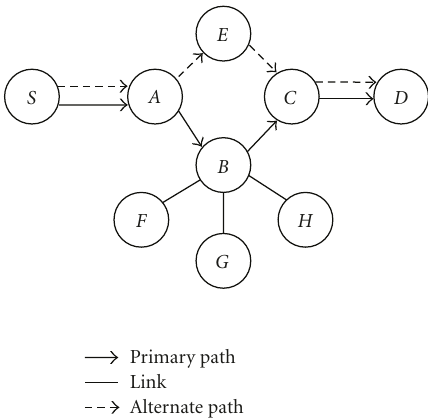
Figure 6: Alternate path